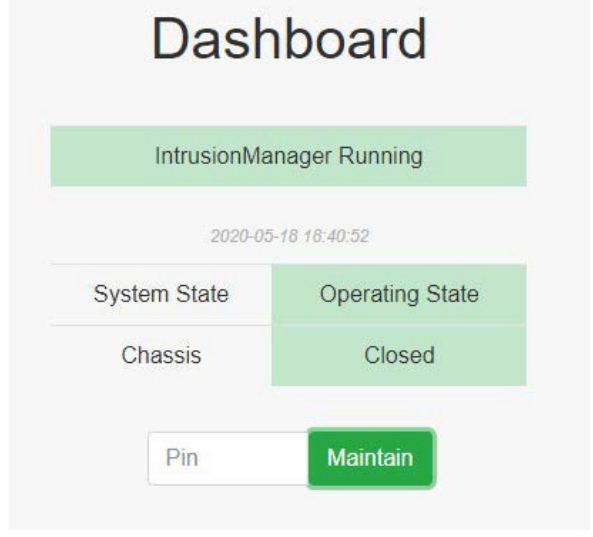
Figure 27. Operating state.